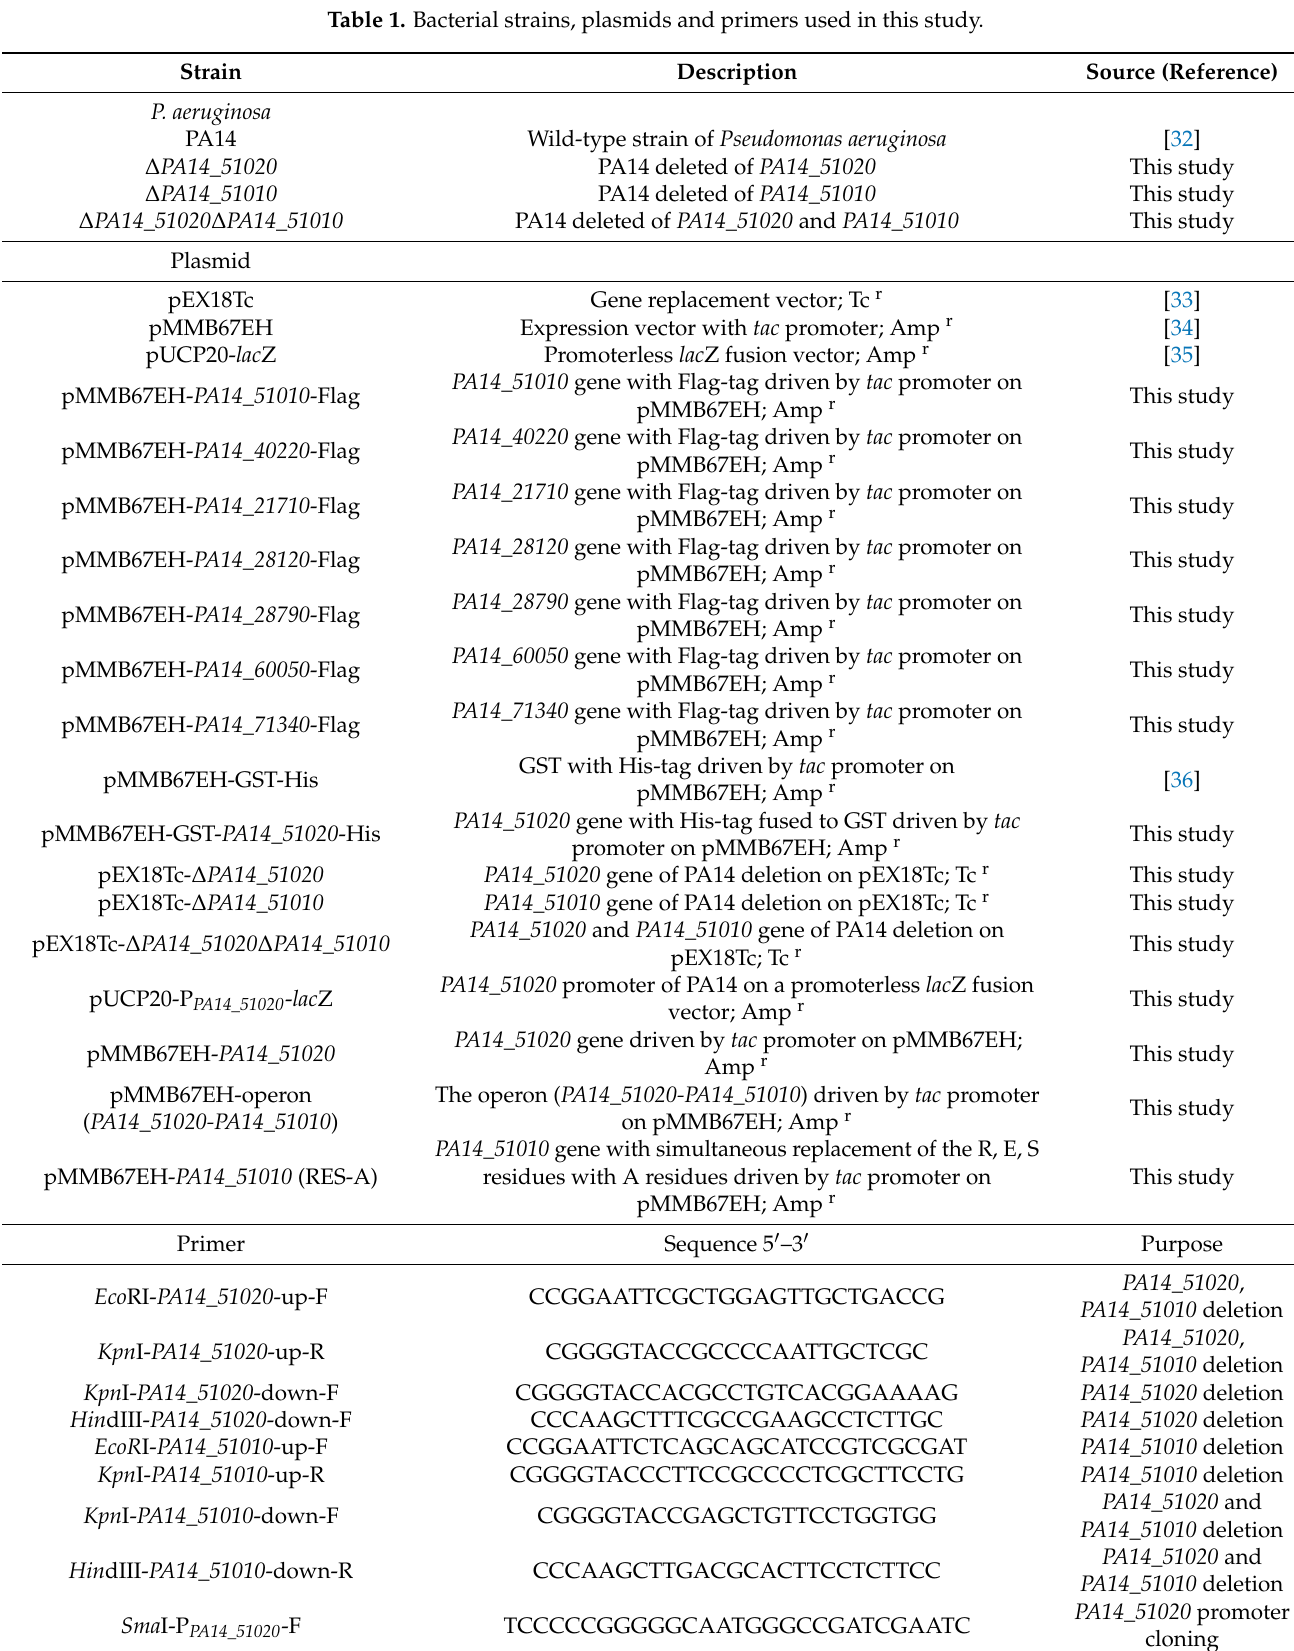
Table 1. Bacterial strains, plasmids and primers used in this